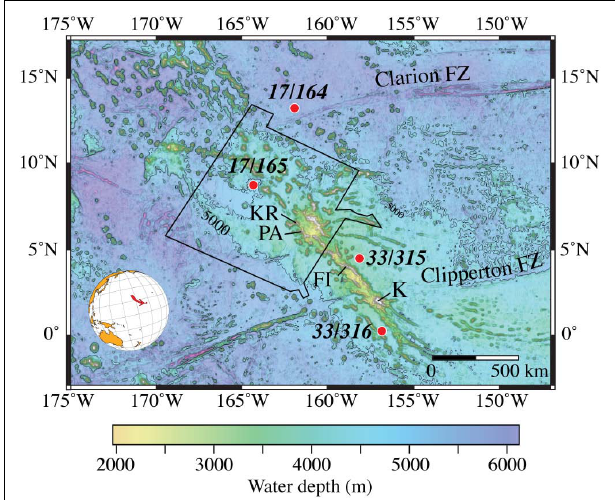
FIGURE 1 | Overview map of the bathymetry of northern Line Islands Ridge, the area between the Clarion and Clipperton Fracture Zones. Bathymetry from GeoMapApp GMRT (Ryan et al., 2009). The solid black line outlines the area covered by this study. Red circle with black italics label indicate DSDP Leg/Site and labels “KR,” “PA,” “FI,” and “K” are locations of Kingman Reef, Palmyra Atoll, Fanning Island and Kiritimati, respectively. Black contours are 5000 m